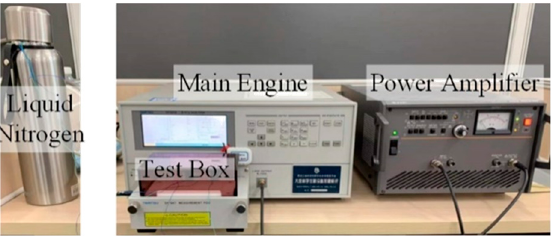
Figure 2. Material measurement device in low-temperature environment.